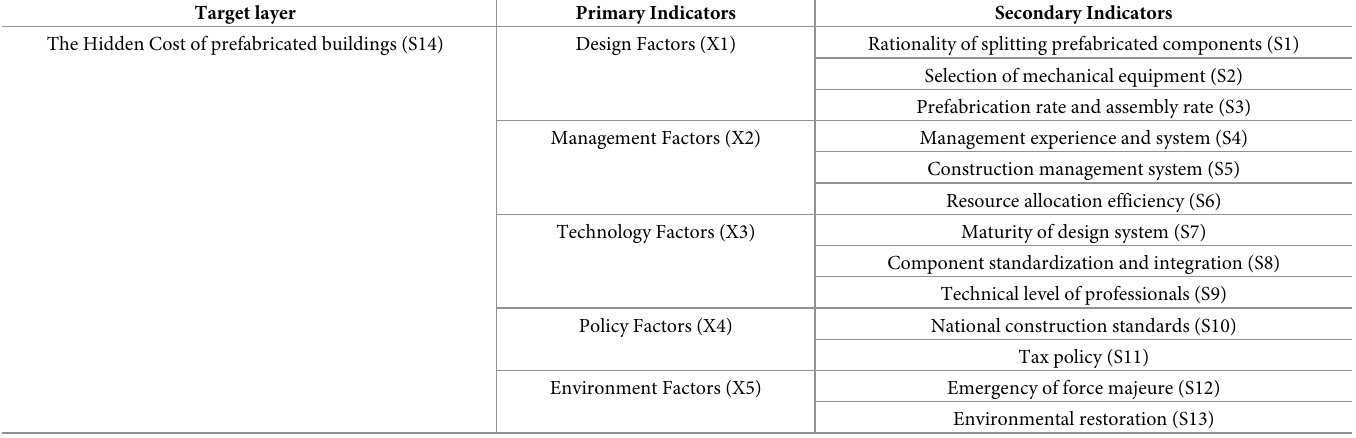
Table 2. Influencing factors of hidden cost of prefabricated